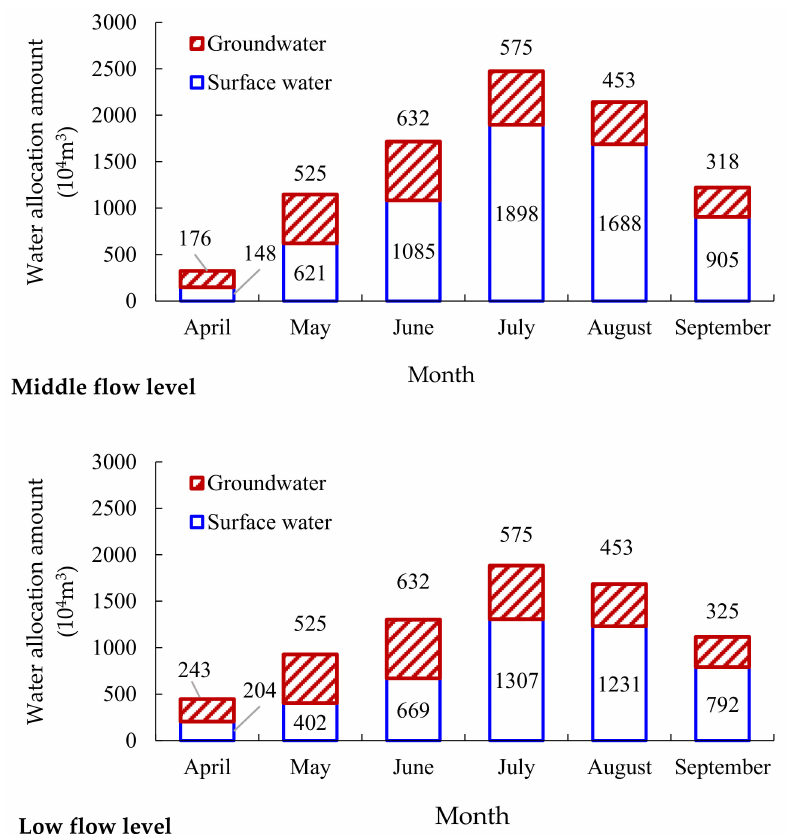
Figure 4. Total irrigation water allocation under different flow levels.